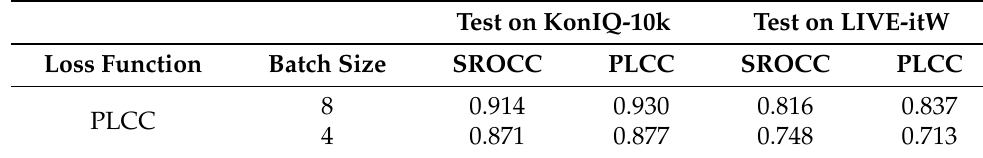
Table 2. Trained model with PLCC-induced loss function to maximize the PLCC with different batch